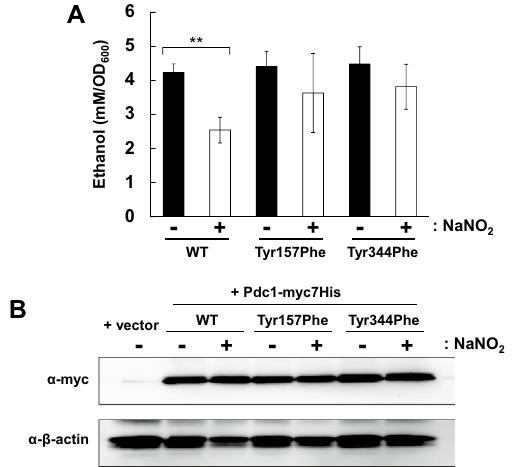
Figure 4. Ethanol production of yeast cells Pdc1 variants resistant to the PTN modification. ( A ) Ethanol contents in the culture medium of yeast producing Pdc1-myc7His with Tyr157Phe or Tyr344Phe substitutions in the presence or absence of acidified nitrite. The values represent the averages and standard deviations from three independent experiments. ** ρ < 0.01 by Student’s t -test. ( B ) Protein extracts from the cells prepared same as ( A ) were analyzed by western blotting with anti-NT antibody. The pdc1 Δ ura3 Δ cells harboring an empty vector pRS416 was used as a negative